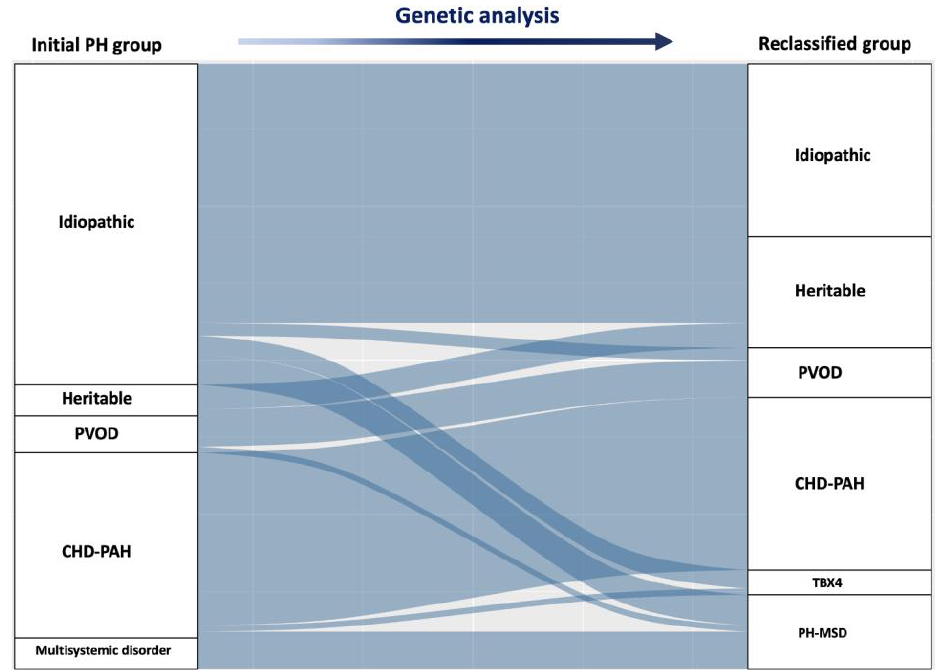
Figure 3. Sankey diagram demonstrating the reclassification of patients after genetic analysis. The left column shows the clinical classification prior to genetic analysis. The right column reflects the clinical classification after reclassification. PAH (pulmonary arterial hypertension); PAH-CHD (pulmonary arterial hypertension associated with congenital heart disease); PVOD (pulmonary veno- occlusive disease). The size of each section represents the number of subjects in each classification; for example, the number of subjects classified with IPAH was lower after reclassification according to genetic testing